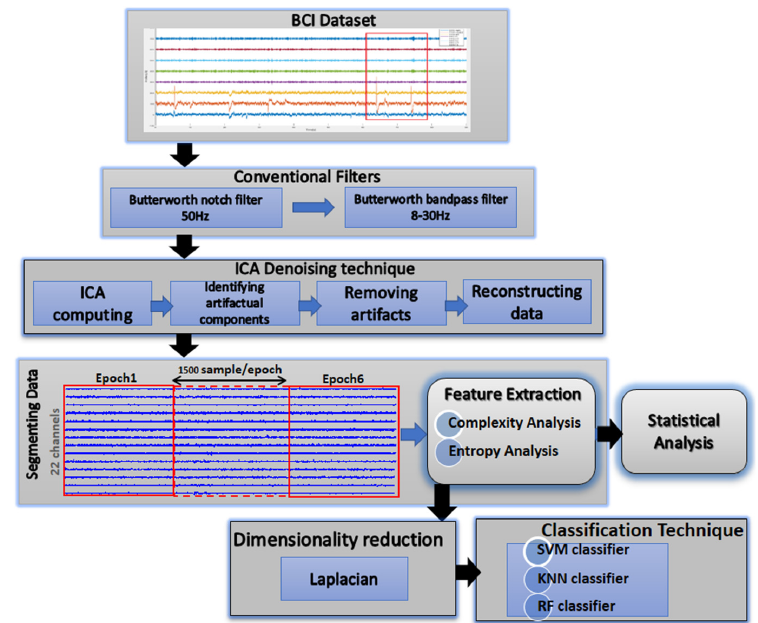
Figure 1. The suggested study’s block diagram.